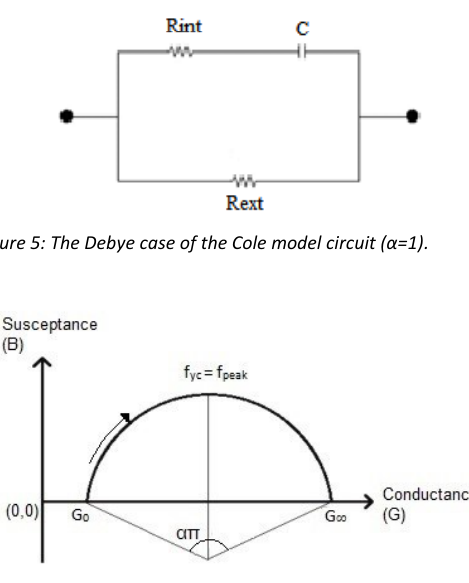
Figure 6: Imaginary part of admittance versus its real part (Cole plot).